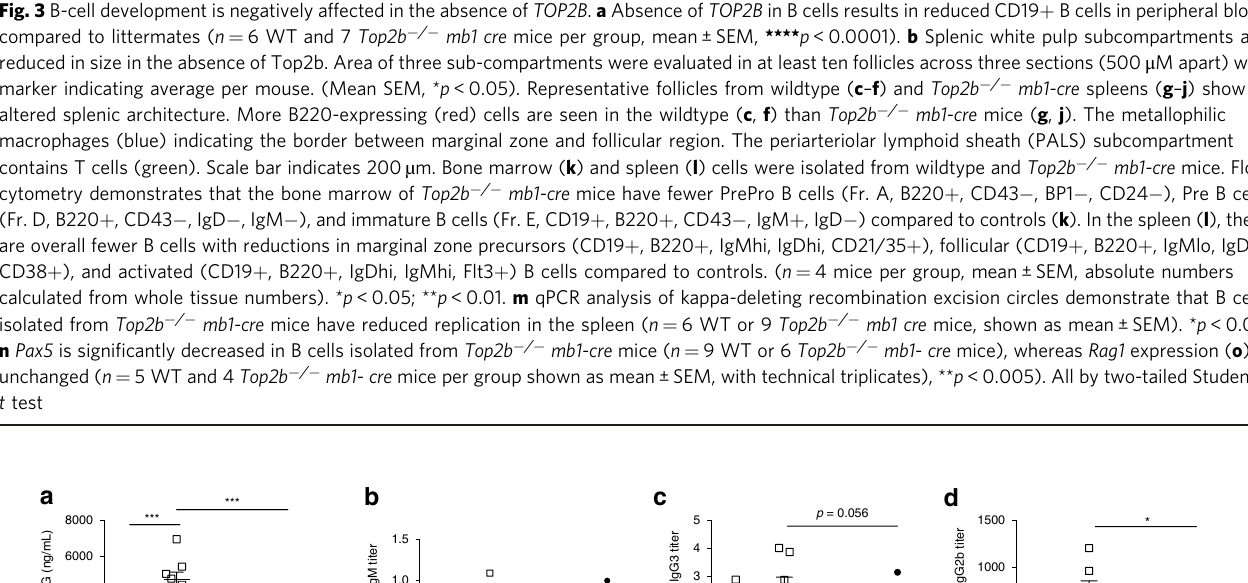
Fig. 3 B-cell development is negatively affected in the absence of TOP2B . a Absence of TOP2B in B cells results in reduced CD19 + B cells in peripheral blood compared to littermates ( n = 6 WT and 7 Top2b − / − mb1 cre mice per group, mean ± SEM, **** p < 0.0001). b Splenic white pulp subcompartments are reduced in size in the absence of Top2b. Area of three sub-compartments were evaluated in at least ten follicles across three sections (500 μ M apart) with marker indicating average per mouse. (Mean SEM, * p < 0.05). Representative follicles from wildtype ( c – f ) and Top2b − / − mb1 - cre spleens ( g – j ) show